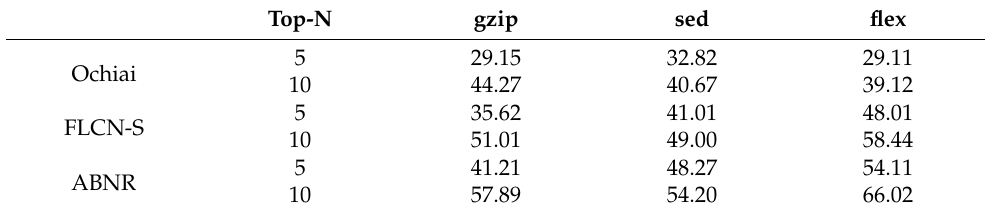
Table 10. Denote the Top-N assessment for faults localized in Unix utility applications.